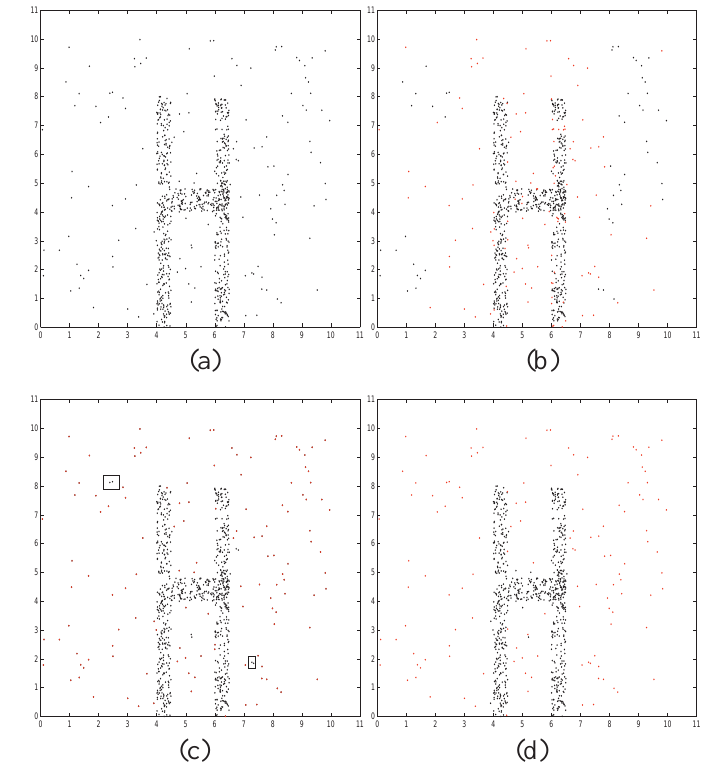
Fig. 3. Outlier detection results. (a) Data points; (b) LOF method; (c) ABOD method; (d) Proposed method. The red points are outliers detected by these methods.